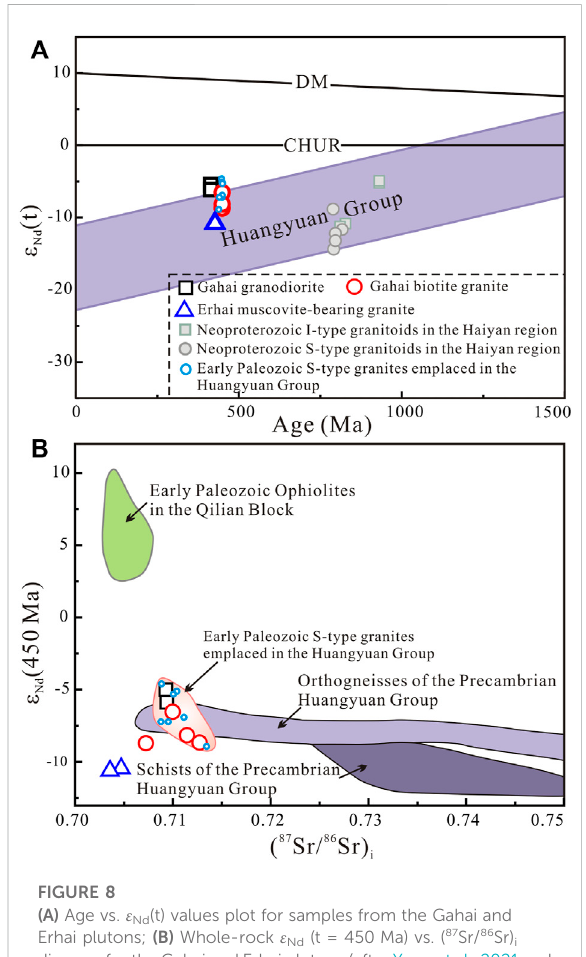
FIGURE 8 (A) Age vs. ε Nd (t) values plot for samples from the Gahai and Erhai plutons; (B) Whole-rock ε Nd (t = 450 Ma) vs. ( 87 Sr/ 86 Sr) i diagram for the Gahaiand Erhai plutons (after Yang etal., 2021 and reference therein). The Nd evolutionary area shown in Figure 8A for the Precambrian basement rocks of the Huangyuan Group is calculated by the data from Tung et al. (2013) and Zhang et al. (2006). The data for the Neoproterozoic and early Paleozoic granitoids in the Haiyan region are from Tung et al. (2016) and Tung et al. (2013), respectively.